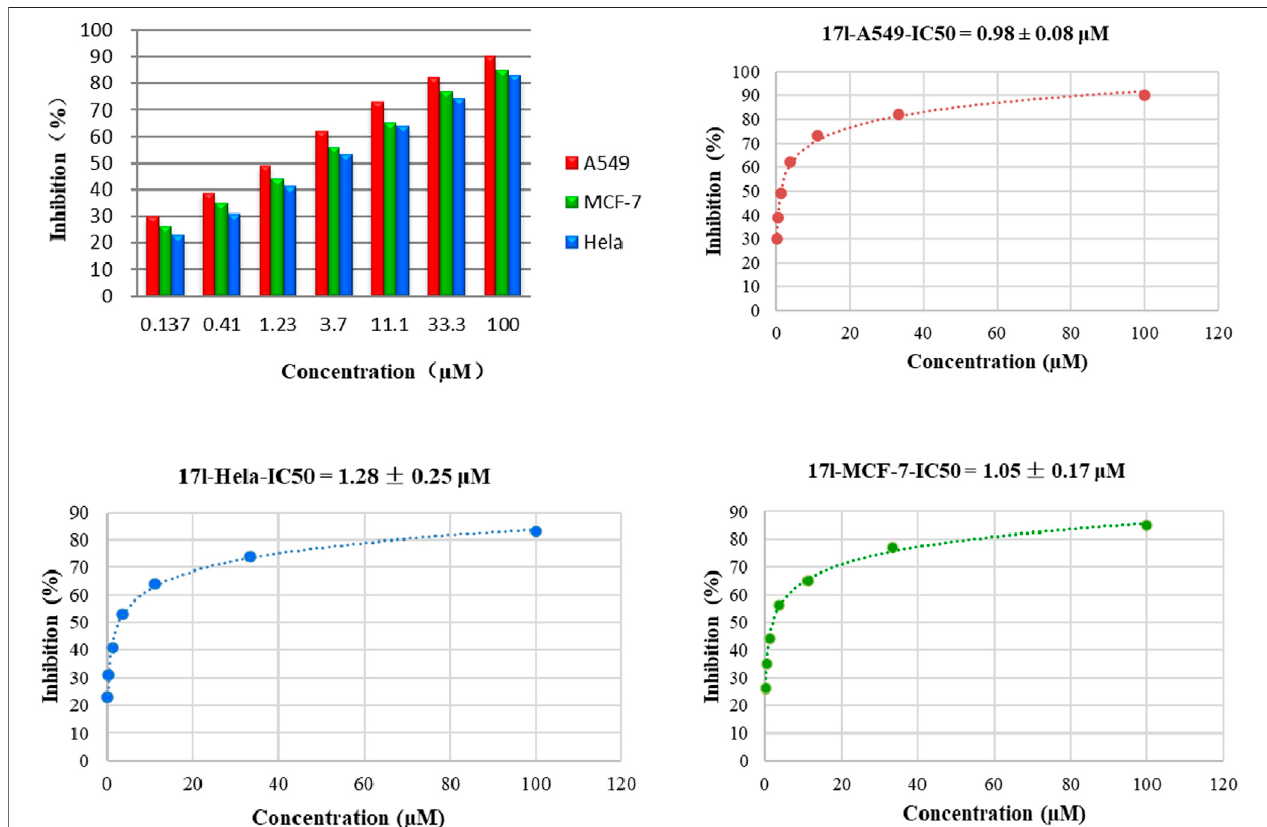
FIGURE 3 | Relationship between the inhibition rate and concentration of compound 17l on three cancer cell lines.